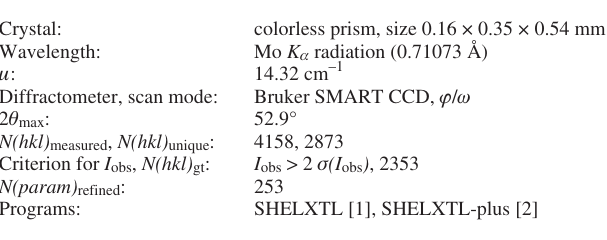
Table 1. Data collection and handling.